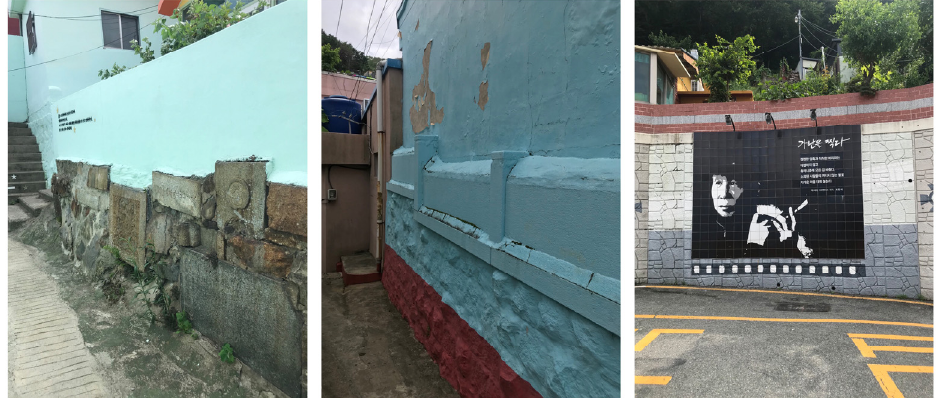
Figure 11. Public Art and remains of the tombstones along the alleyways.